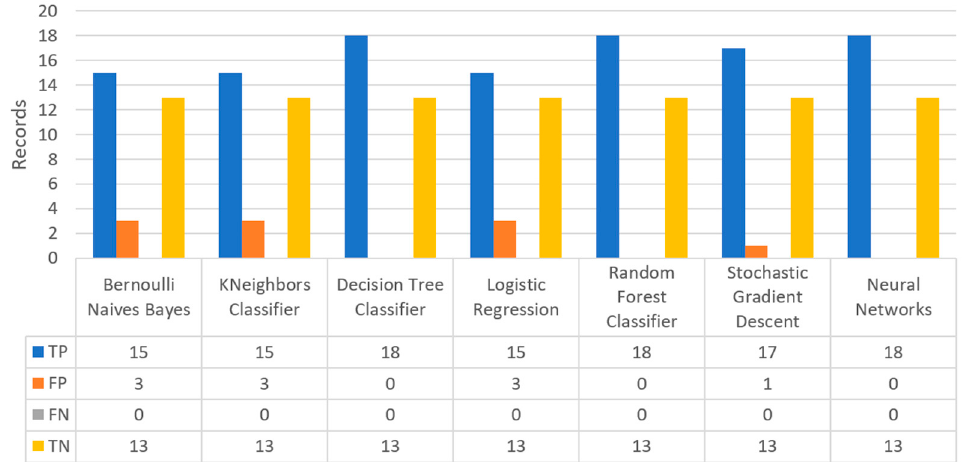
Figure 31. Confusion matrix of prediction results for kidney disease use case.